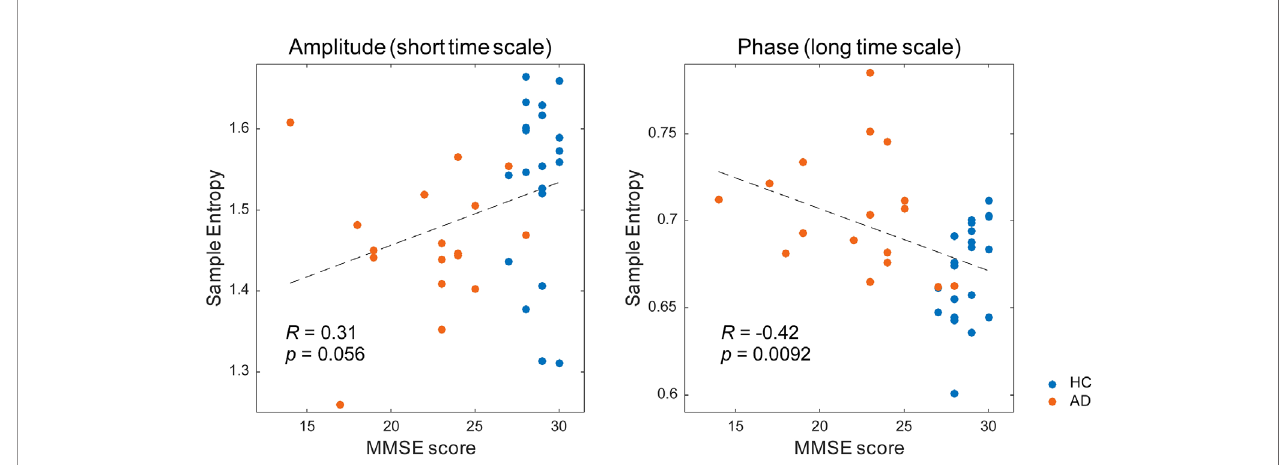
FIGURE 5 | Correlation between the multiscale entropy (MSE) values and the Mini-Mental State Examination (MMSE) scores. The MMSE scores showed a mild positive correlation with the amplitude complexity on the short time scale (SF = 20, r = 0.31, p = 0.056) and a signi fi cant negative correlation with the phase complexity on the long time scale (SF = 60, r = − 0.42, p = 0.0092).